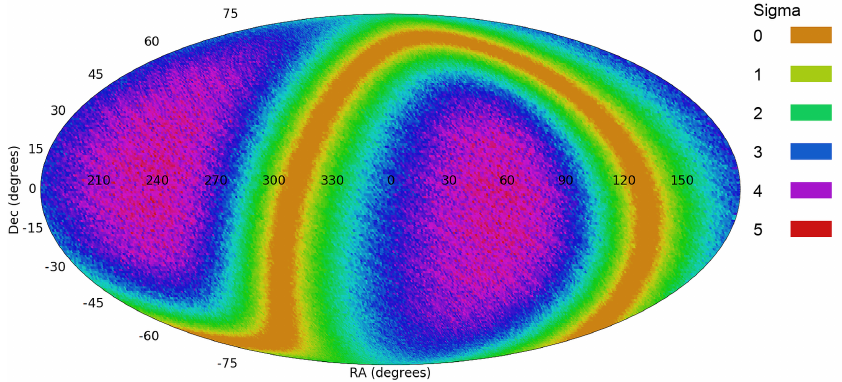
Figure 8. The statistical significance of a dipole axis from all integer ( α , δ ) combinations in a dataset of 958,841 galaxies from SDSS, DESI Legacy Survey, Pan-STARRS, and HST.